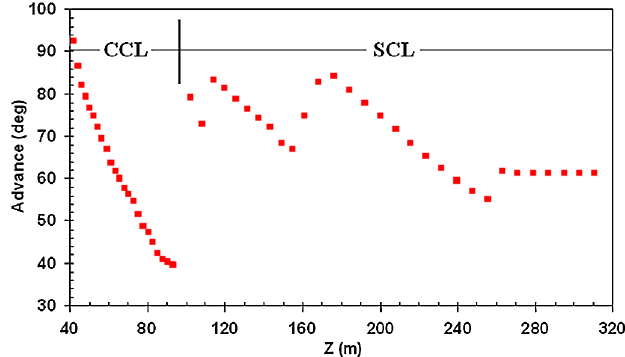
FIG. 2. (Color) Cell-by-cell zero-current transverse phase ad- vance of the CCL and SCL baseline design lattice. Half of the CCL lattice is below 60 (cid:1) , while most SCL cells (cid:4) 60 (cid:1) .